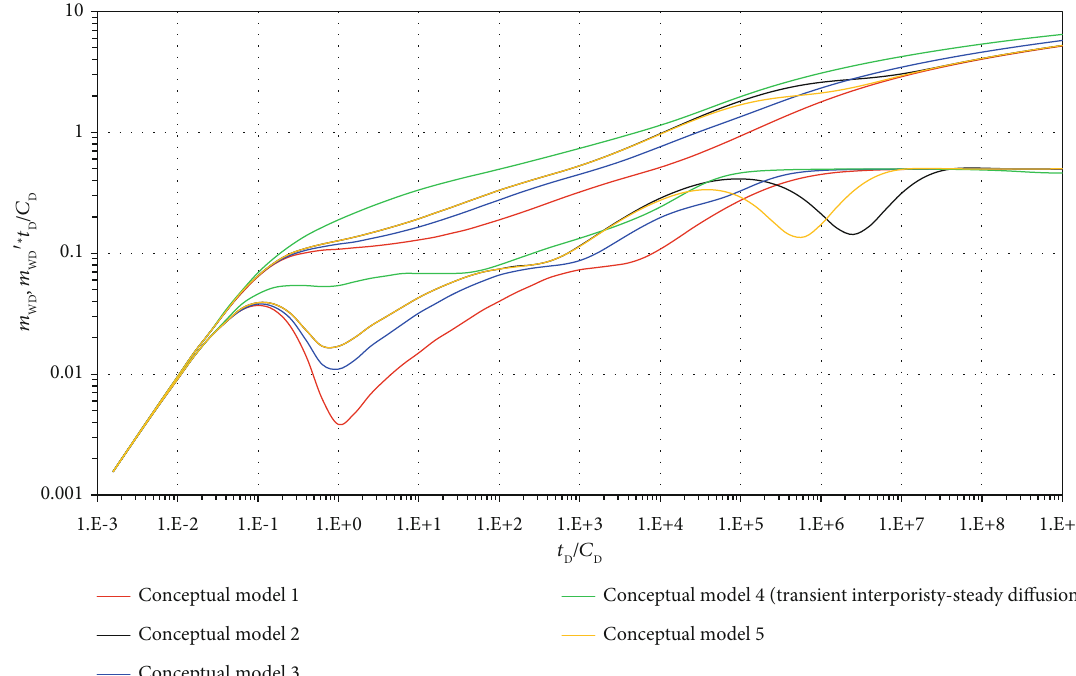
Figure 12: Type curves of fractured horizontal well with di ff erent conceptual